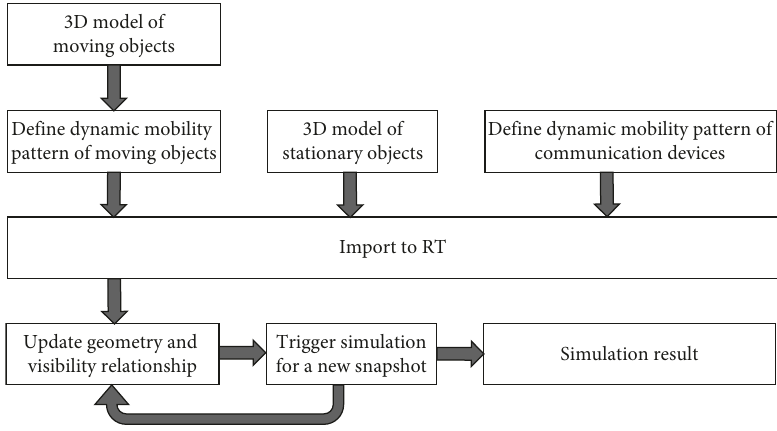
Figure 8: Workflow of simulating moving environments. Table 2: Electromagnetic parameters of different materials.